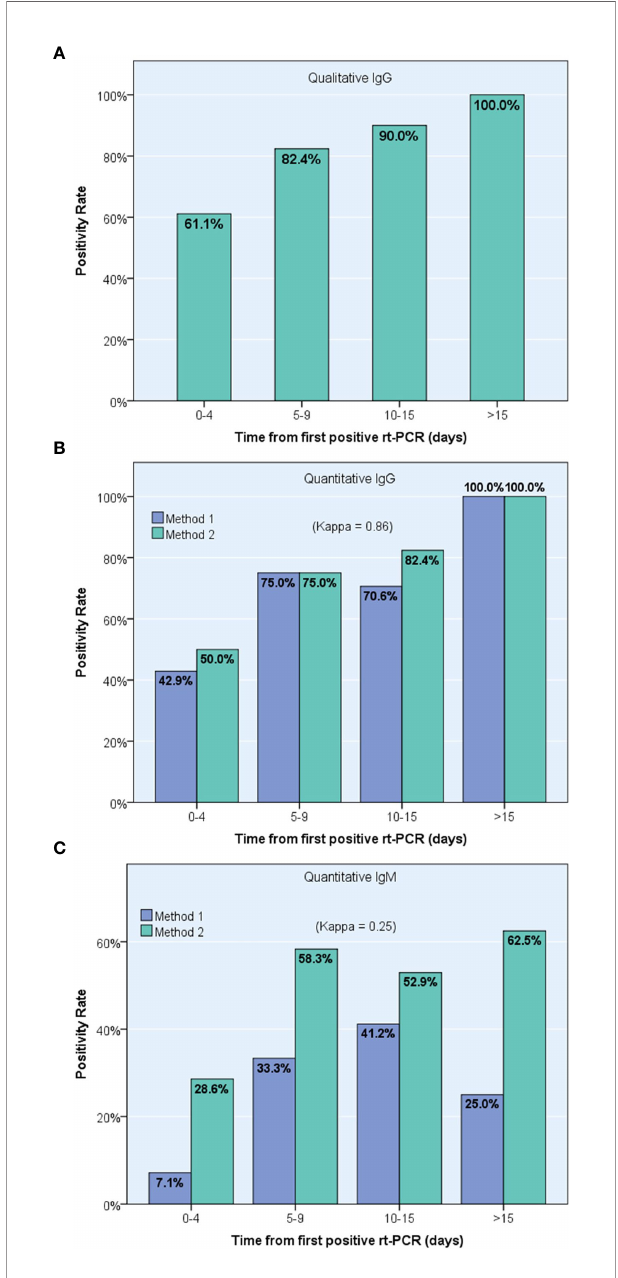
FIGURE 4 | Progression over time of positive detection of speci fi c anti-Sars- Cov-2 antibodies using pooled results from 23 con fi rmed COVID-19 patients, including one IgG qualitative immunoassay (A) and two different IgG (B) and IgM (C) quantitative immunoassays, ANSH (Method 1) and AESKU (Method